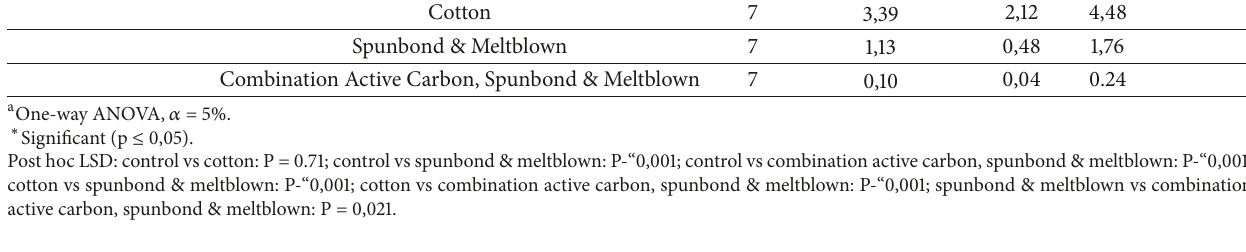
Table 2: Effectiveness of the use of masks and exposure to SOx.